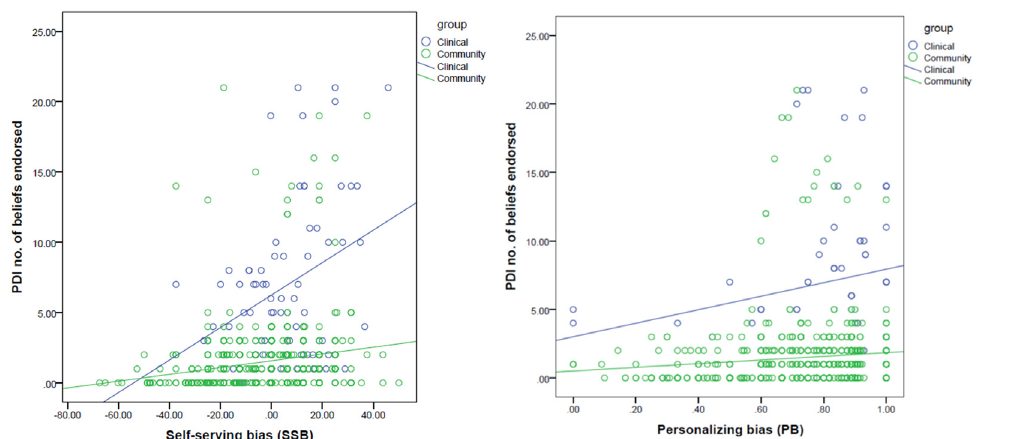
Fig 1. Association between attributional biases and number of delusional ideations.